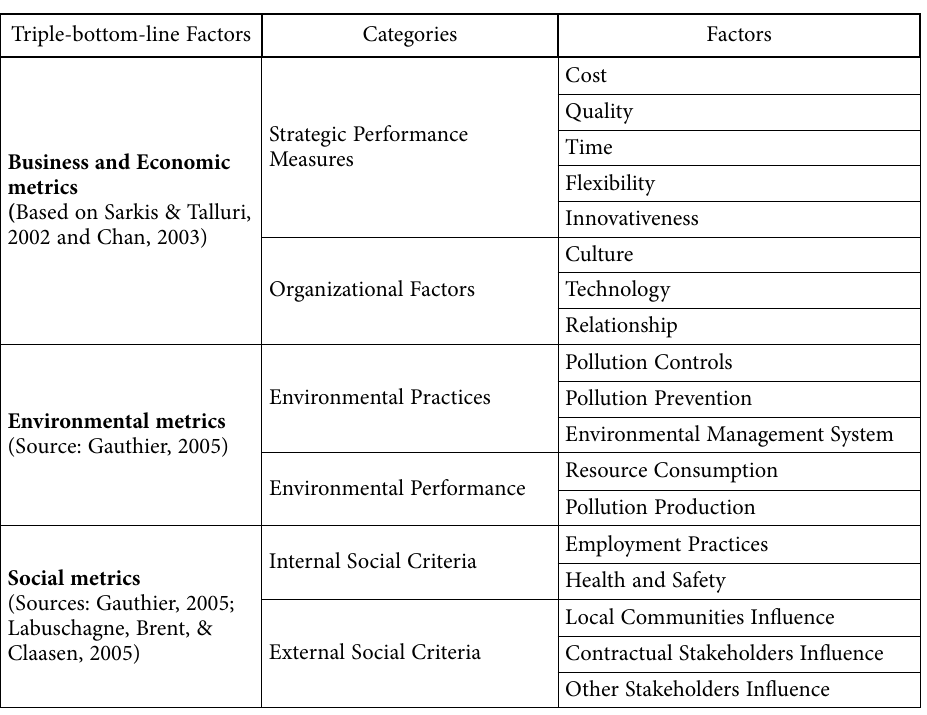
Table 1. Sustainability supplier selection